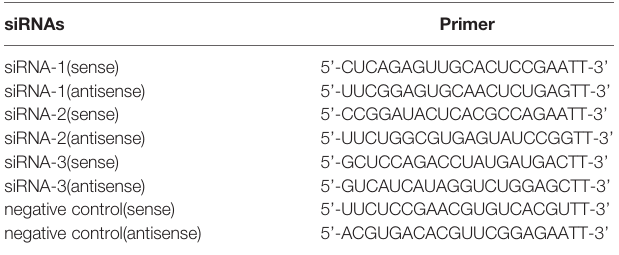
TABLE 1 | The primer sequences for small-interfering RNAs (siRNAs) targeting GDF15.